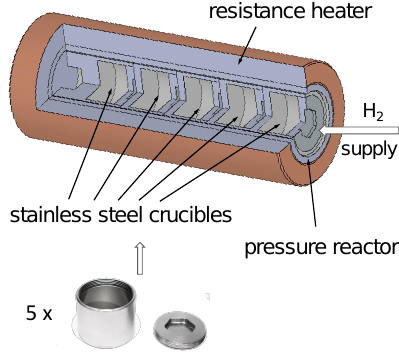
Figure 1. Custom-made reactor for the synthesis of multiple